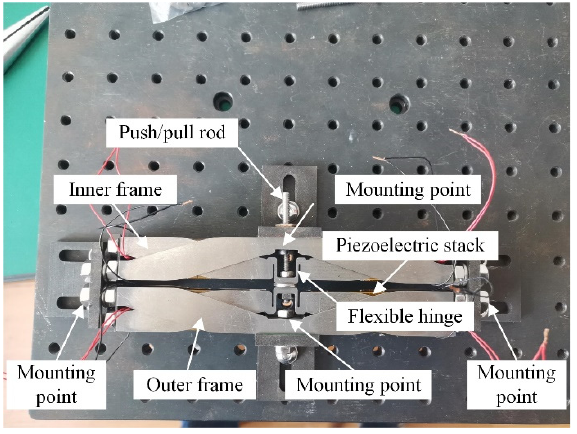
Figure 9. Prototype of the actuator.